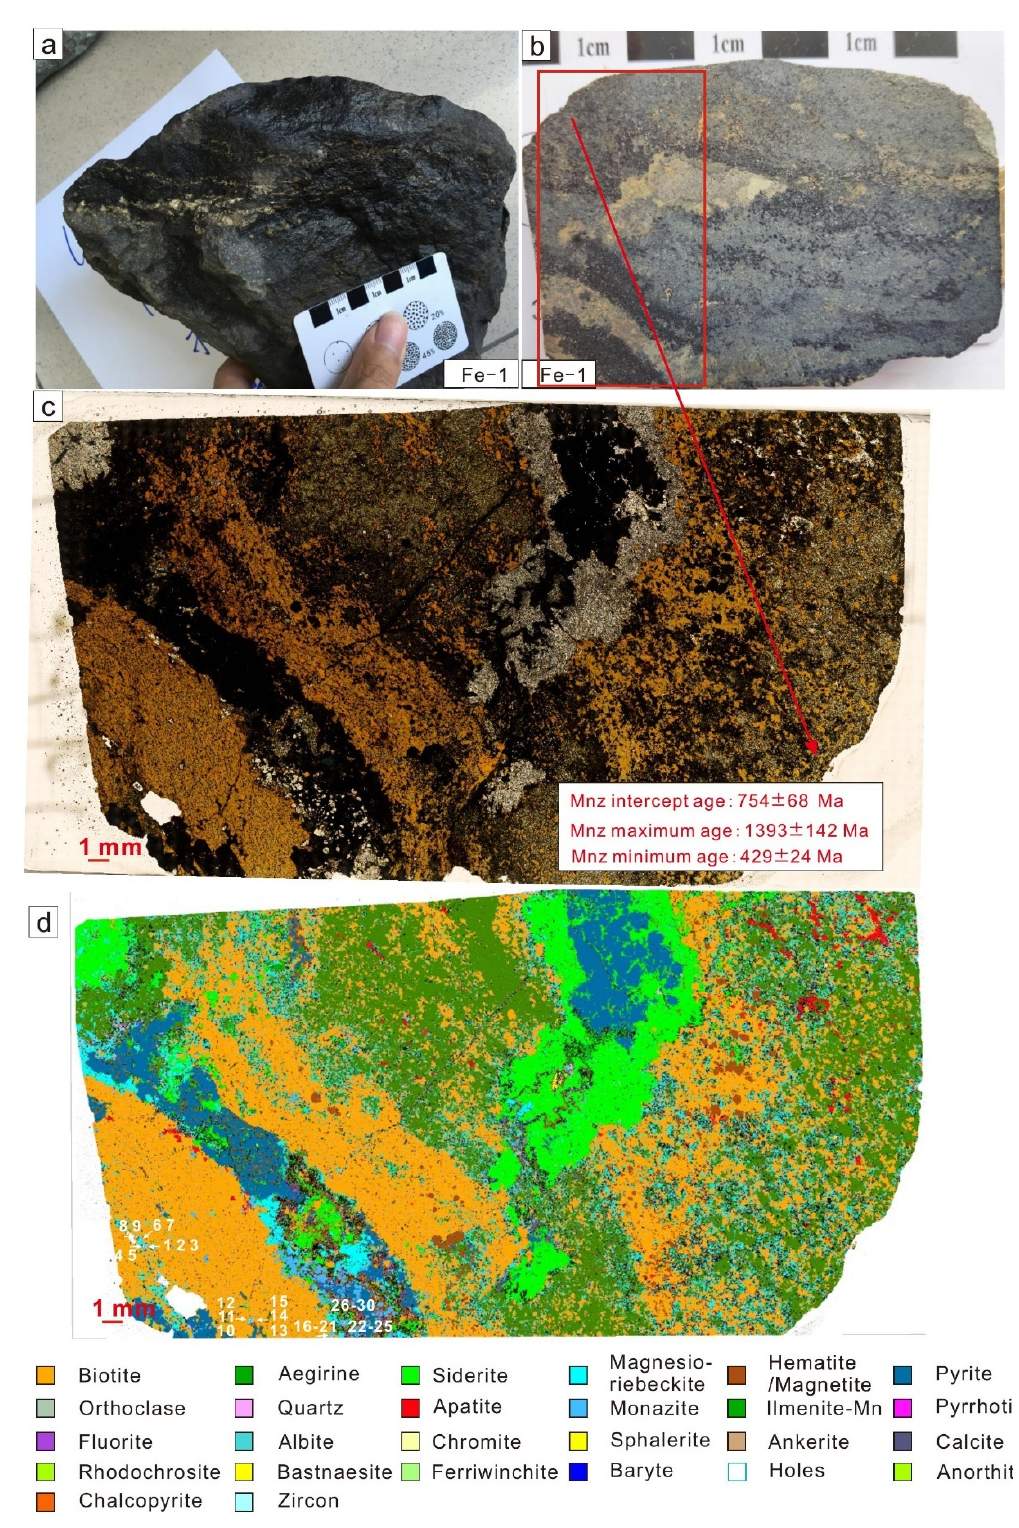
Figure 4. The petrological characteristics of sample Fe-1. ( a ) Hand specimen; ( b ) photograph of the polished surface of the sample, ( c ) panoramic photomicrograph under transmitted light; ( d ) TIMA mineral maps. The red box in ( b ) is the location of the thin section of ( c ).